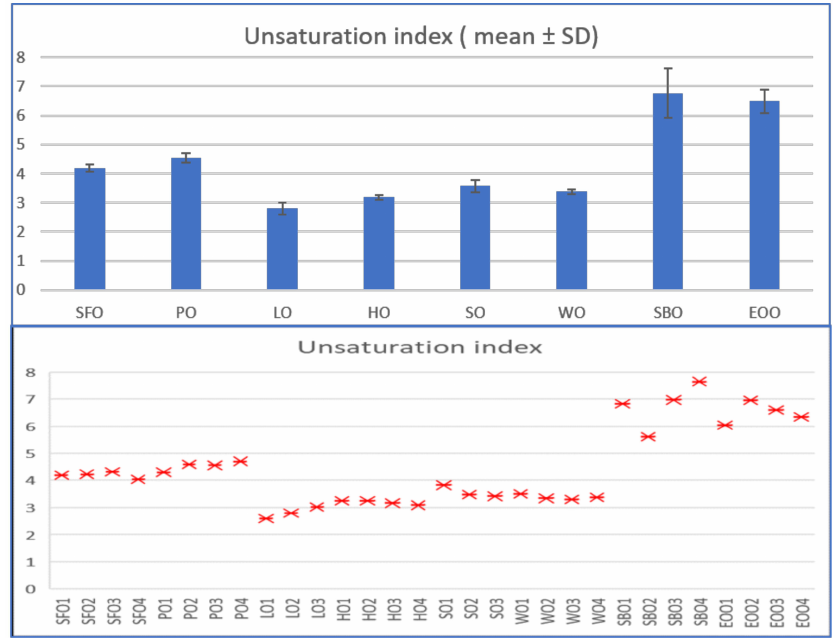
Figure 4. Mean (upside) and individual (downside) values of the unsaturation index, reflecting the features of the 8 groups of oils, as well as the similarities among oils. SFO—Sunflower oil; PO—Pumpkin oil; LO—Linseed oil; HO—Hempseed oil; SO—Soybean oil; WO—Walnut oil; SBO—Sea buckthorn oil; EOO—Olive